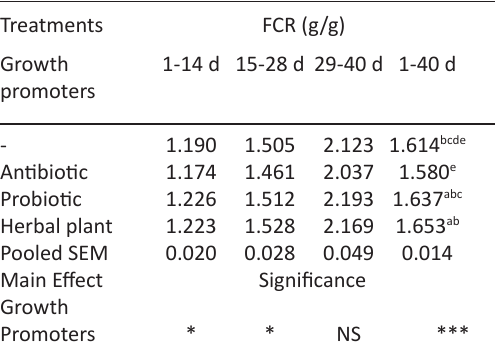
Table 3. Effects of different growth promoters on feed conversion ratio (FCR) and productivity efficiency index (PEI) of Broilers 1 (1-40 days of age)